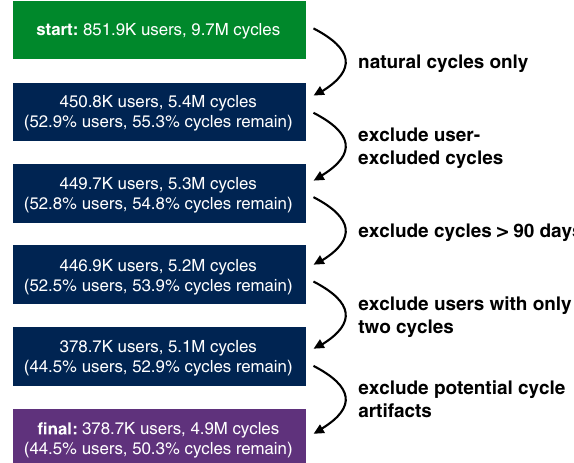
Fig. 6 Filtering process for computing user and cycle cohort. Step- by-step fi ltering process for computing the fi nal user and cycle cohort. The percentage of users and cycles removed at each step is computed out of the initial numbers. Note that we only include users aged between 21 and 33 years, since women exhibit more stable menstrual behavior in their ‘ middle life ’ phase 18,22,29,65,66